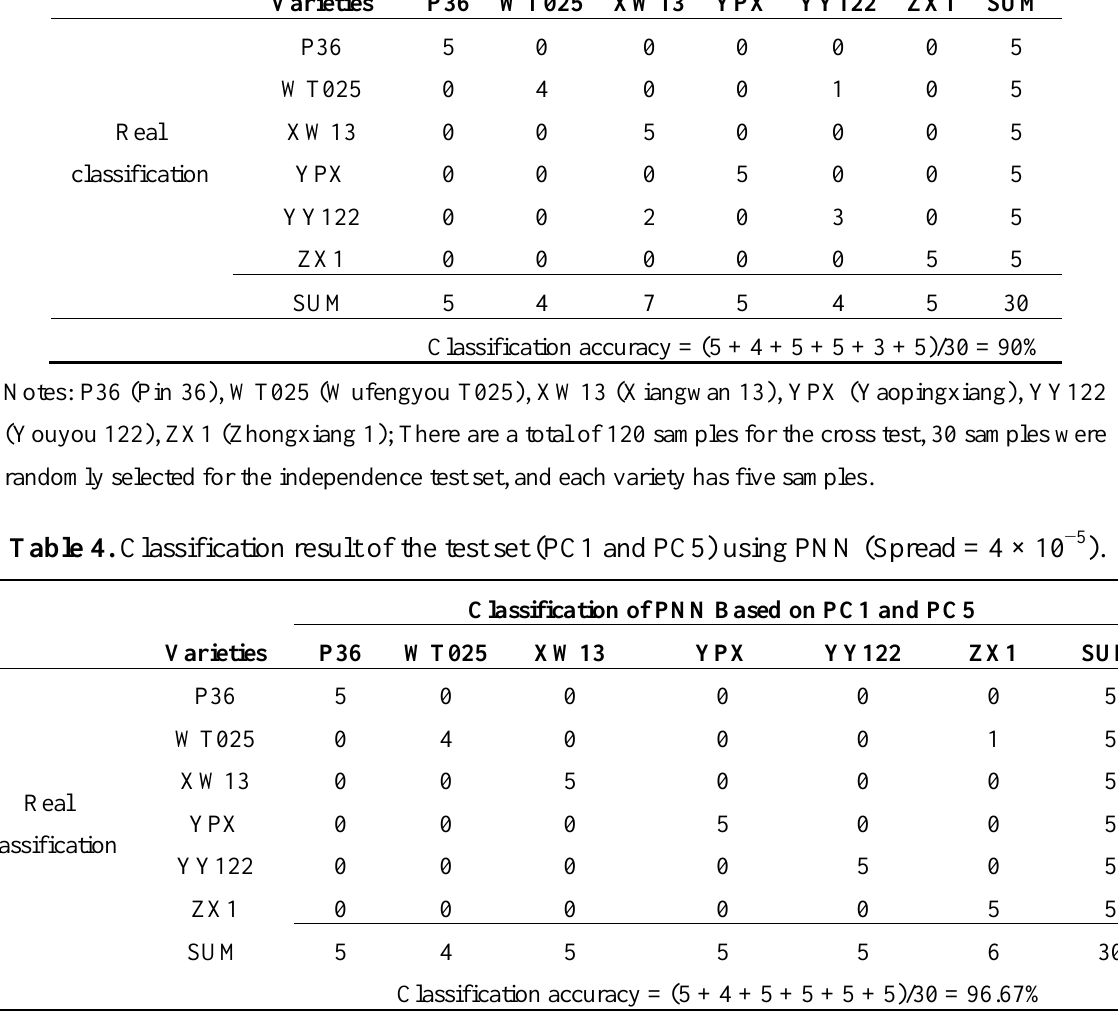
Real classification